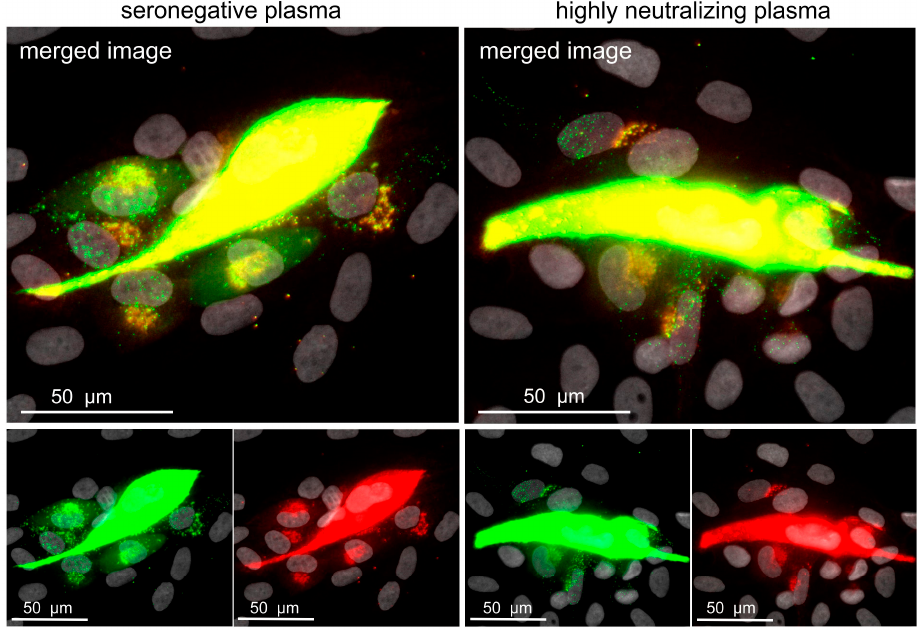
Figure 5. Highly neutralizing plasma does not reduce the number of transferred viral